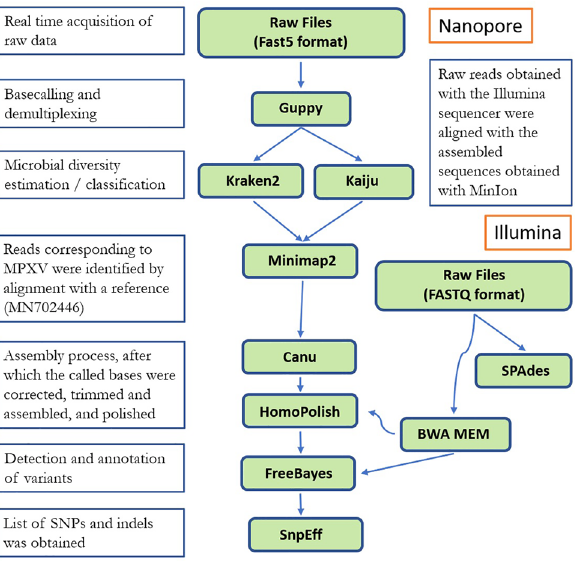
Figure 1. Workflow for the analysis of raw data, from real-time acquisition to the listing of SNPs and